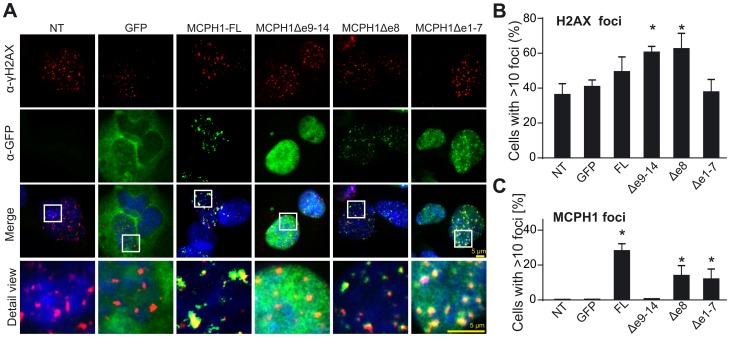
Colocalization of MCPH1 and γH2AX in ionizing irradiation-induced nuclear foci.(A) Non-transduced (NT) MCPH1-deficient 562T cells and 562T stably expressing GFP alone or the specified GFP-MCPH1 fusion proteins were fixed 2 h after irradiation with 10 Gy and co-stained with antibodies against γH2AX (red) and GFP (green). Nuclei were counterstained with DAPI (blue). Rectangles frame areas, which are shown enlarged in the bottom row. MCPH1 focus formation was observed for MCPH1 isoforms containing the C-terminal BRCT tandem. (B) Quantification of cells expressing foci containing γH2AX and/or (C) MCPH1. Error bars indicate the S.D. of three different measurements, counting approximately 300 nuclei. * p≤0.05 vs. NT as calculated using the Student's t-test.